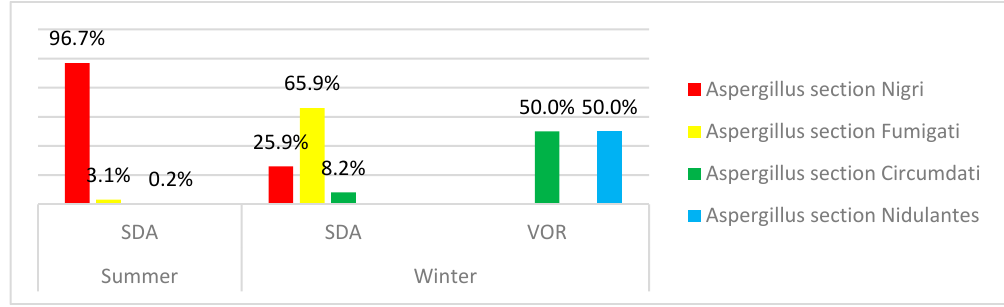
Figure 3. Aspergillus sections identified in summer and winter EDC samples by the azole screening Figure 3. method.